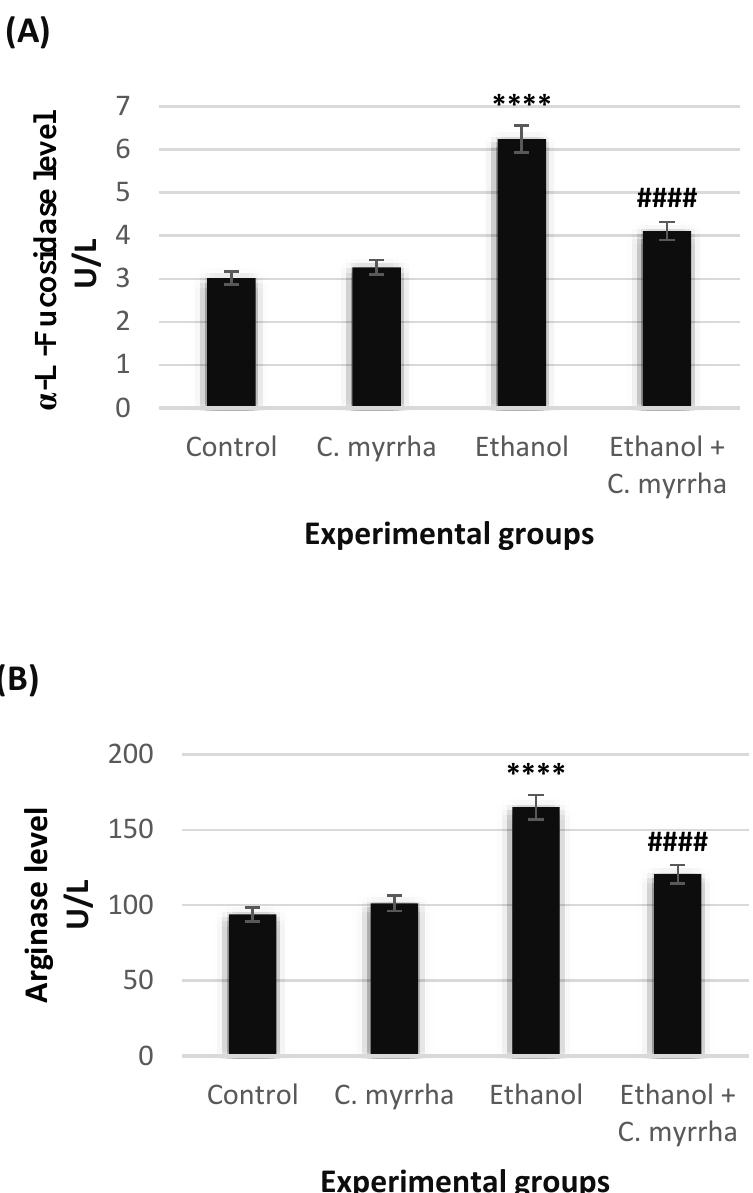
Figure 2. Effects of C. myrrha extract (500 mg/kg) and/or ethanol (40%, 3 g/kg) on hepatic tumor markers in serum after 30 days of treatment. ( A ) α -L fucosidase level expressed as units per liter (U/L). ( B ) Arginase level expressed as units per liter (U/L). All values are expressed as mean ± standard error (SE) of n = 7. **** p < 0.0001 vs. control; #### p < 0.0001 vs. ethanol-treated group.